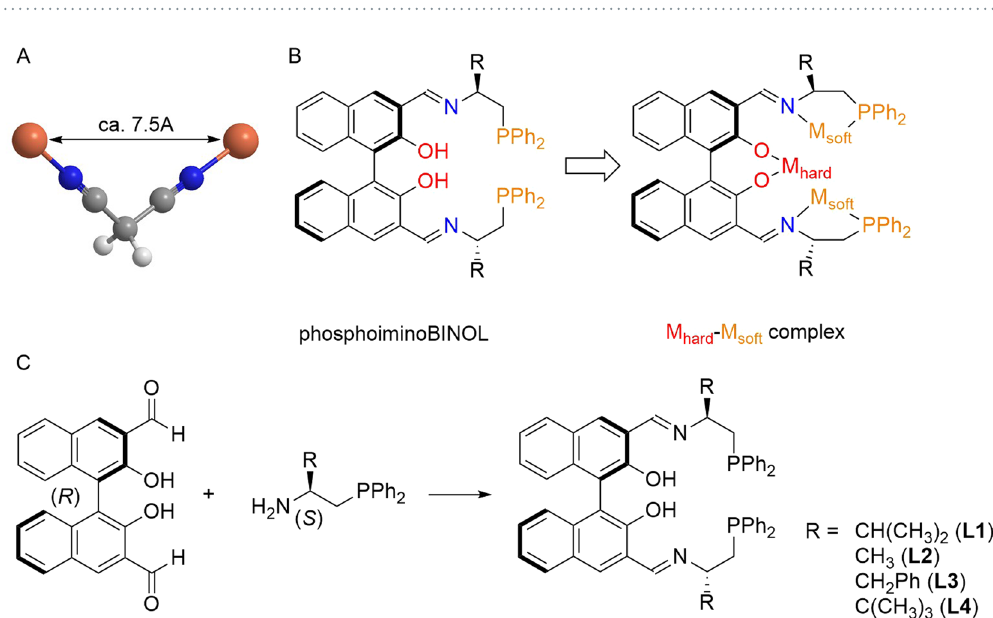
Figure 2. Design of Malononitrile Container. ( A ) Geometry of malononitrile bound to two metals, ( B ) Design of the multifunctional dinuclear phosphoiminoBINOL-metal complex for binding malononitrile. ( C ) Preparation of phosphoiminoBINOL